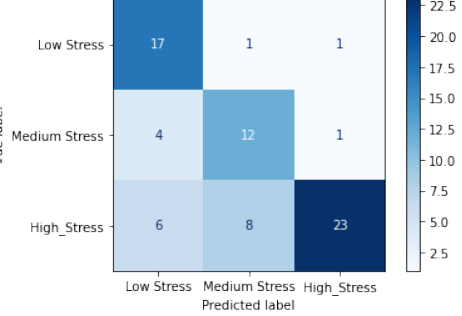
Figure 6. Confusion matrix for contrastive SSL model on the RML dataset.